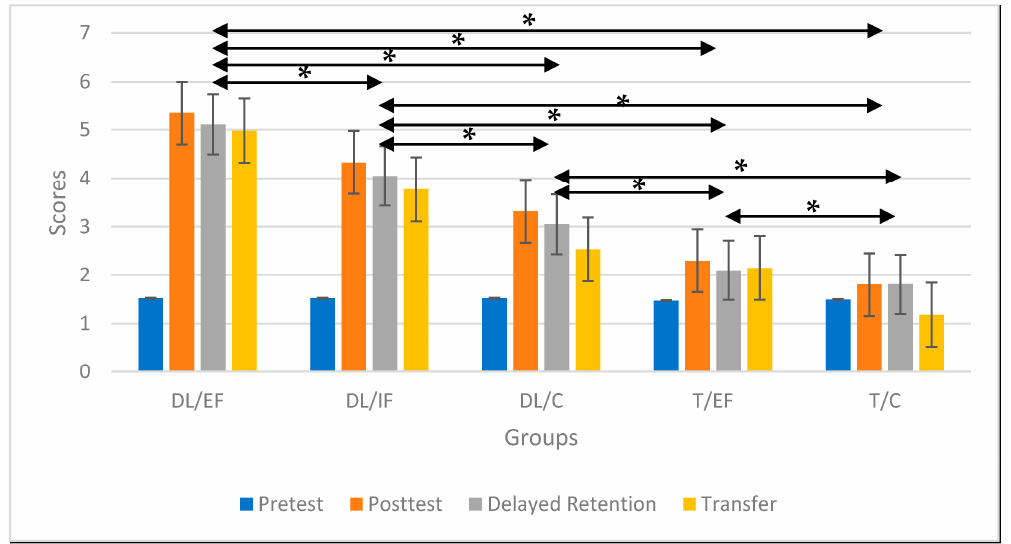
Figure 3. Average scores and standard deviations of pre-, post-, retention and transfer test results for the five intervention groups. DL/EF: differential learning with an external focus; DL/IF: differential learning with an internal focus; DL/C: differential learning without a specific focus; T/EF: traditional repetitive training with an external focus; T/C: traditional repetitive training without a specific focus. * Major statistically significant differences between groups (in all tests, a significant difference was observed between all groups).